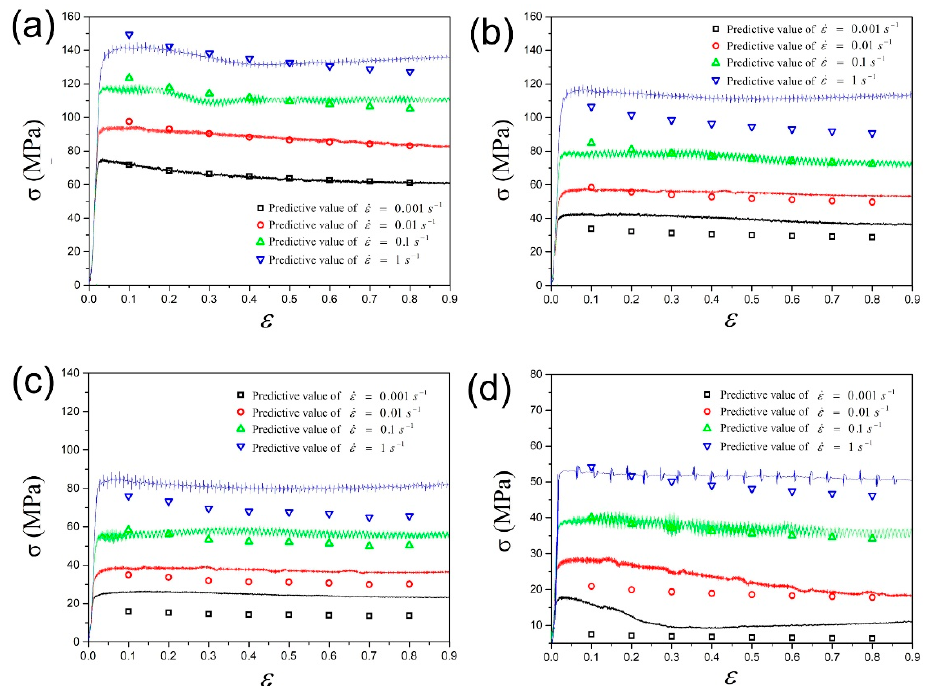
Figure 5. Comparison between the predictive value of the constitutive model fitted by a second- order polynomial and the experimental stress-strain curves at temperature of ( a ) 320 °C, ( b ) 380 °C, ( c ) 440 °C and ( d ) 500 °C, respectively.